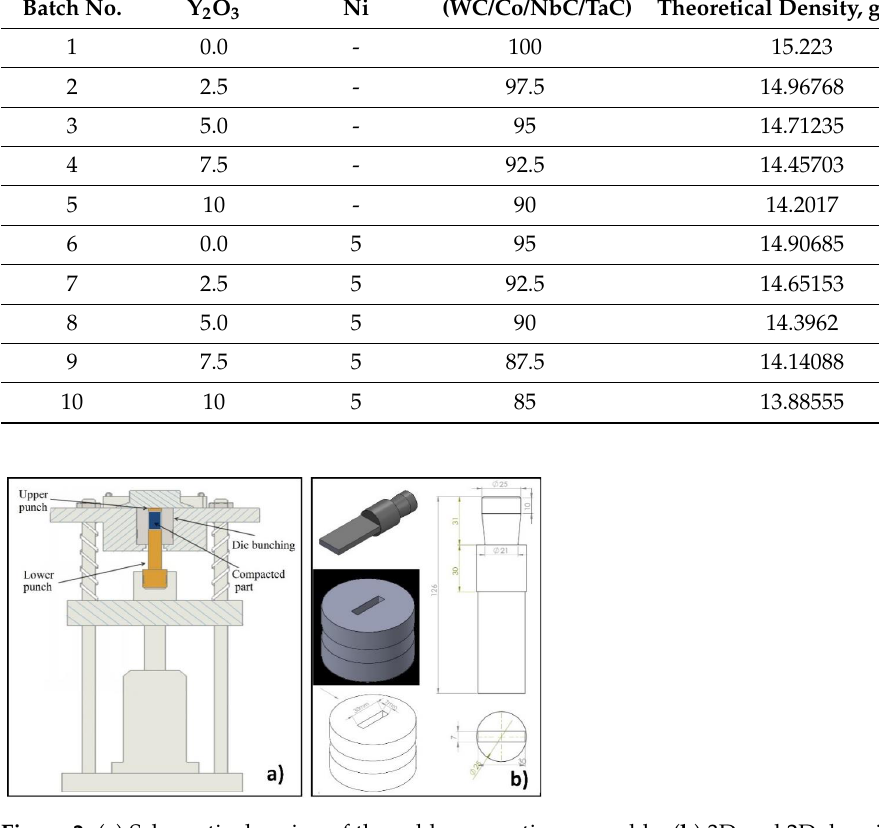
Figure 2. ( a ) Schematic drawing of the cold-compaction assembly. ( b ) 3D and 2D drawings of the rectangular die. All dimensions in ( b ) are in mm.